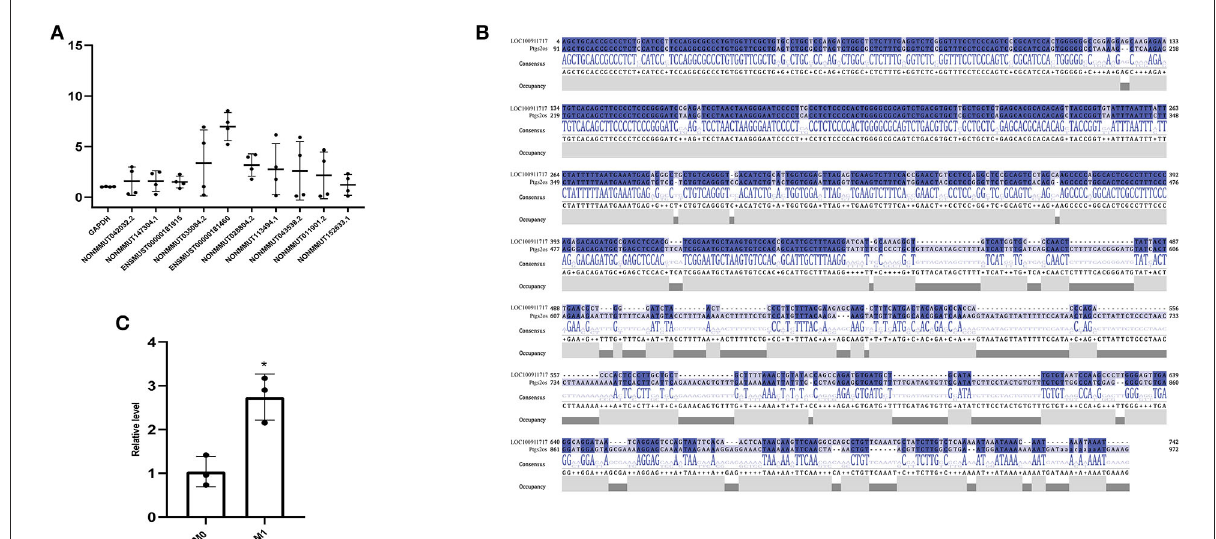
FIGURE3 Comparison of lncRNA expression between the M0- and M1-type macrophages or between the sham group and the MI group and nucleotide sequence alignment. (A) Comparison of lncRNA expression between M0- and M1-type macrophages. (B) lncRNA LOC100911717 and lncRNA